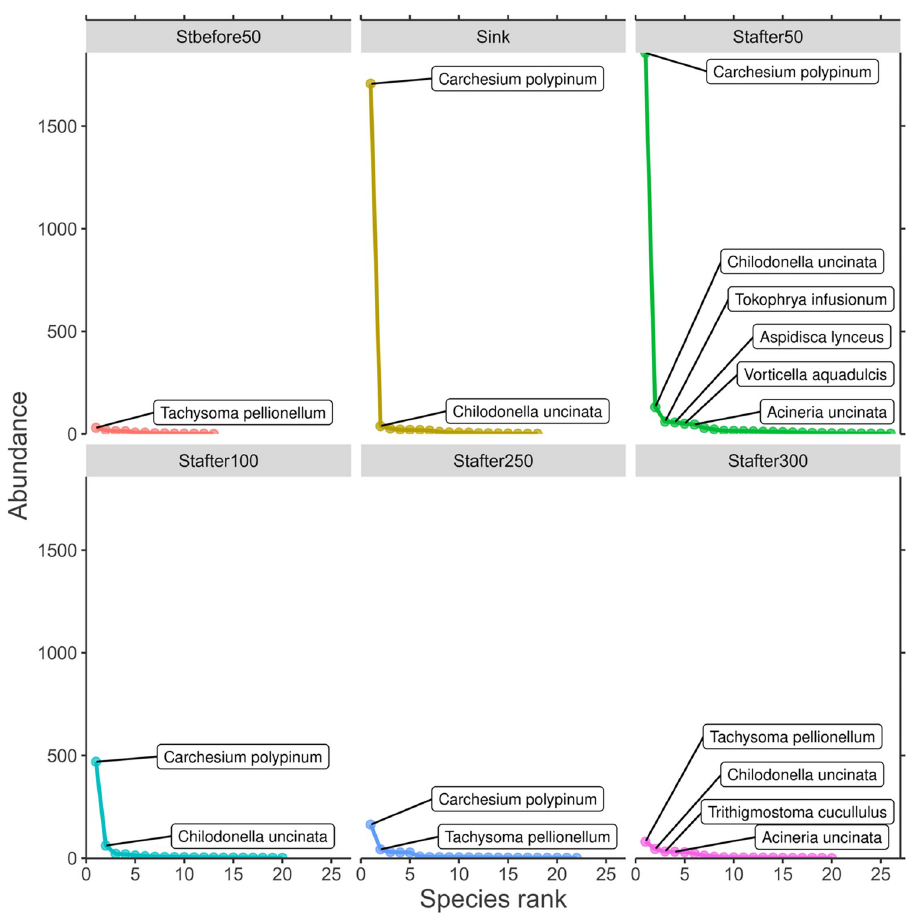
Fig 8. Rank-abundance plots by stations in an environmental gradient based on averaged data for the entire study period.